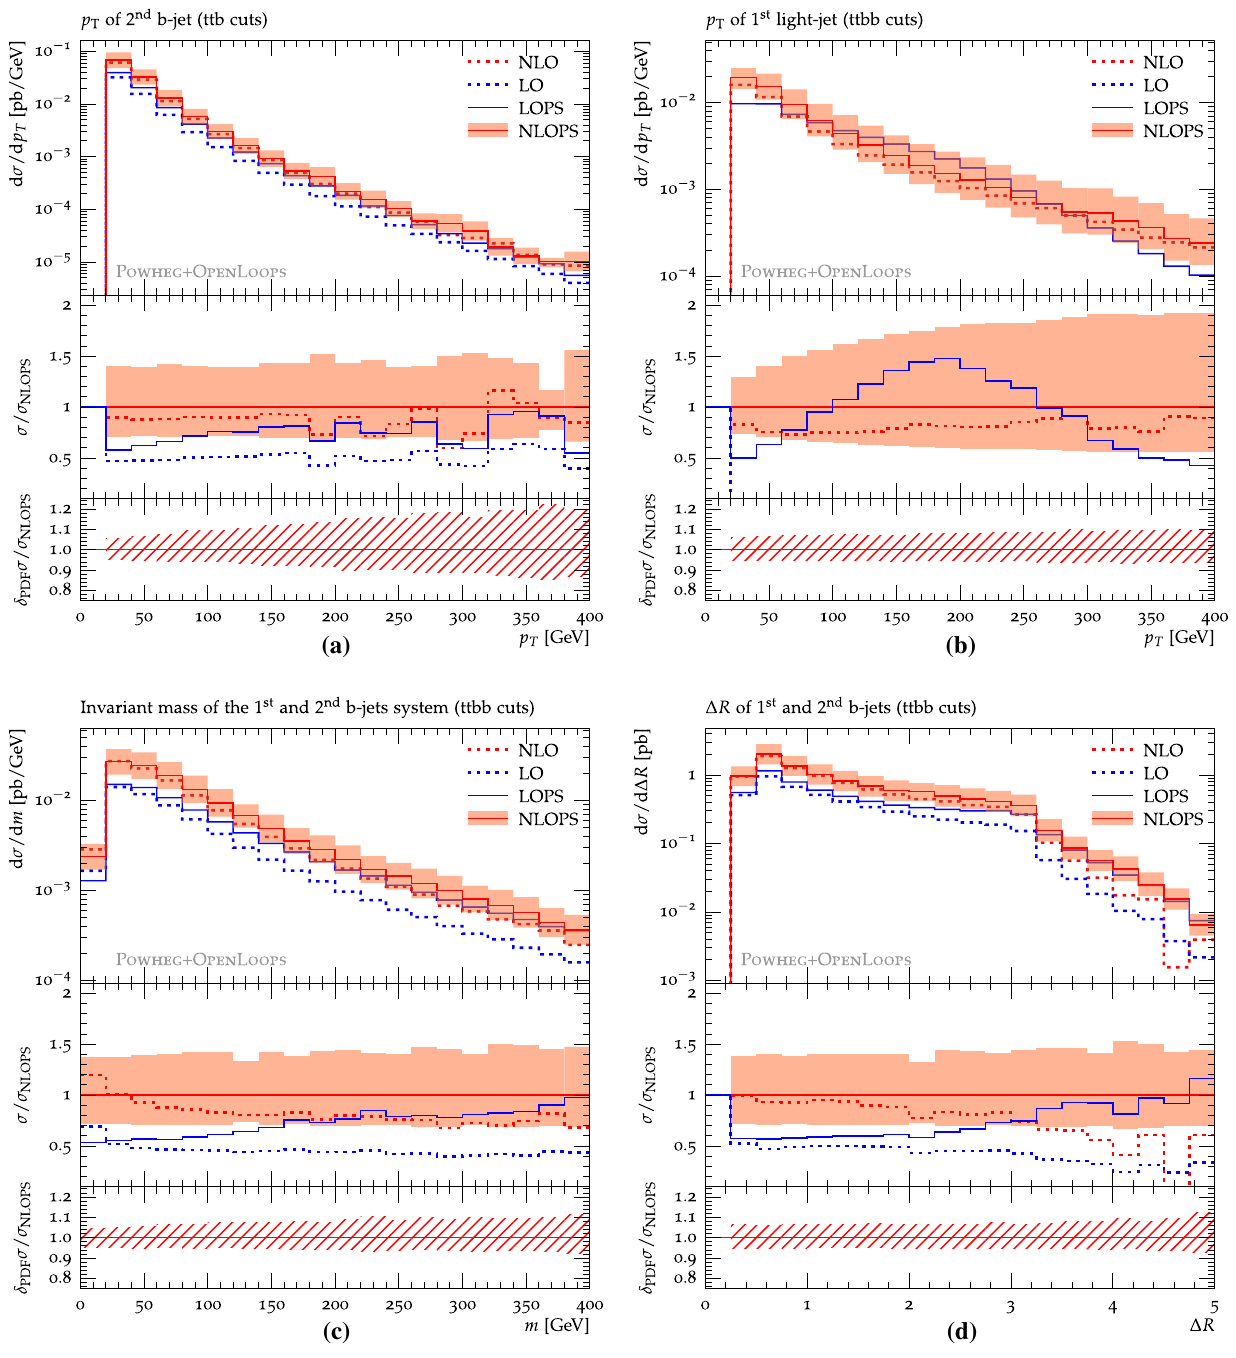
Fig. 8 Distributions in the p T of the second b -jet ( a ) in the p T of the first light jet ( b ), and in the invariant mass ( c ) and the Δ R separation ( d ) of the first two b -jets with ttbb cuts throughout. Predictions and uncertainties as in Fig.